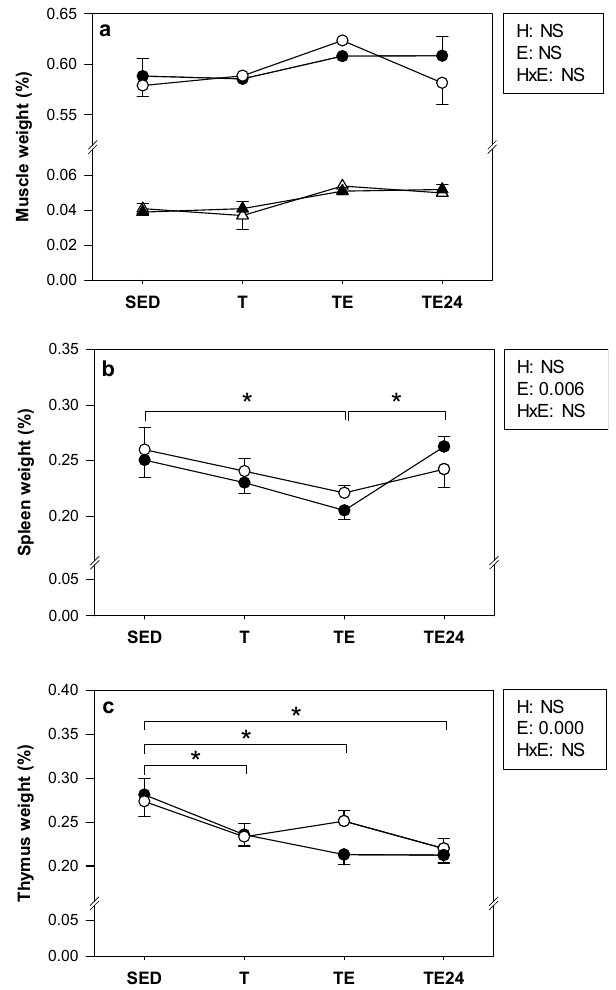
Figure 3. Relative weight of gastrocnemius muscle ( a , circles), soleus muscle ( a , triangles), spleen ( b ) and thymus ( c ) at the end of the study. The non-supplemented groups are represented by white symbols ( ⚪ ) and the hesperidin groups by black symbols ( ⚫ ). SED = sedentary groups, T = trained groups, TE = T groups with an additional exhaustion test, TE24 = TE groups 24 h after the exhaustion test, NS = no statistically significant differences detected. Data are expressed as mean ± SEM ( n = 7–8). Statistical difference: the inset table shows two-way ANOVA results when applied (H, hesperidin; E, exercise, HxE, interaction between hesperidin and exercise). * p < 0.05 between exercise conditions for both the non-supplemented and the hesperidin-supplemented groups.